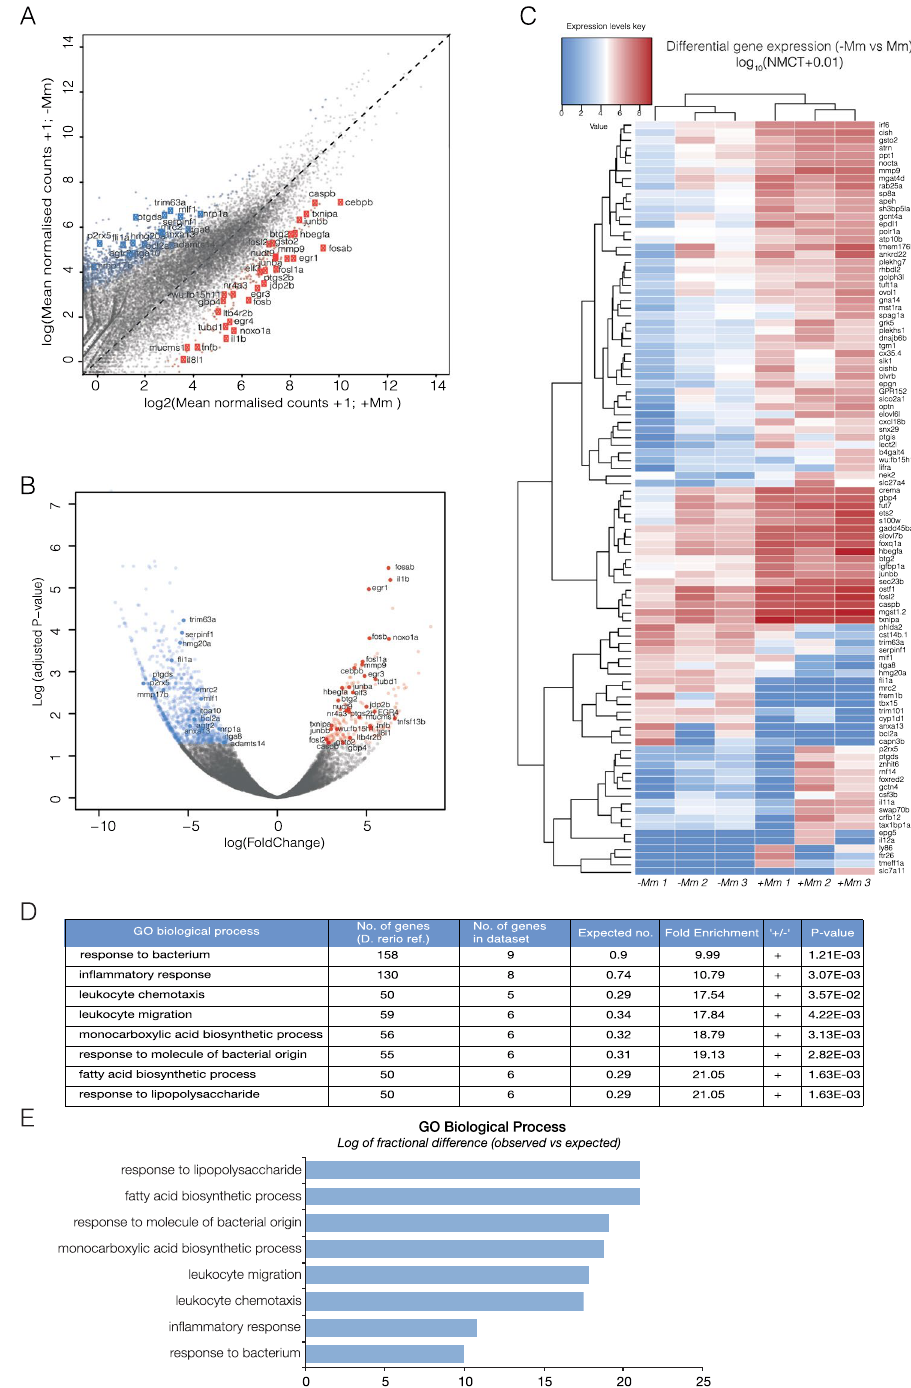
Figure 2. In vivo biotinylation of neutrophil nuclei and RNA-seq analysis reveal transcriptomic signature in response to M . marinum infection. ( A ) Scatterplot of log (Mean DESEq2 normalised counts (NMCT) + 1) comparing M . marinum infected and uninfected controls show 189 upregulated genes (red) and 1100 downregulated genes (blue). ( B ) Volcano plot of DESEq2-generated differential expression analysis of embryos injected with M . marinum vs uninjected controls shows the relationship between p-value and log fold change (red-upregulated; blue-downregulated; grey-not significantly differentially expressed). ( C ) Heatmap shows the log 10 (normalised counts (NMCT) + 0.01) of selected differentially expressed transcripts (adjusted p-value < 0.05). Red - high expression. White - medium expression Blue - low expression. ( D ) Gene ontology enrichment analysis of upregulated genes following Mm infection. ( E ) Bar plot shows significantly overexpressed biological